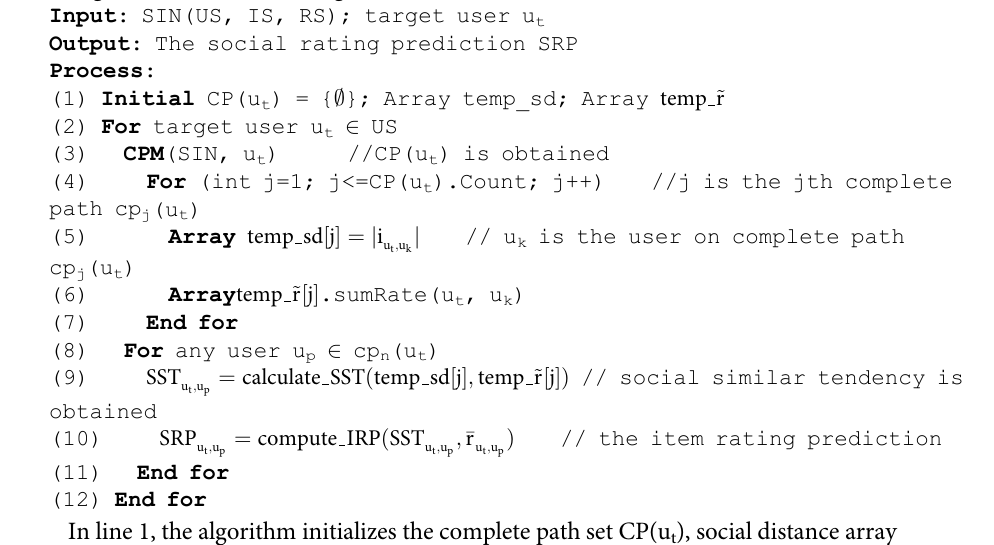
Algorithm 3 : The SRUI